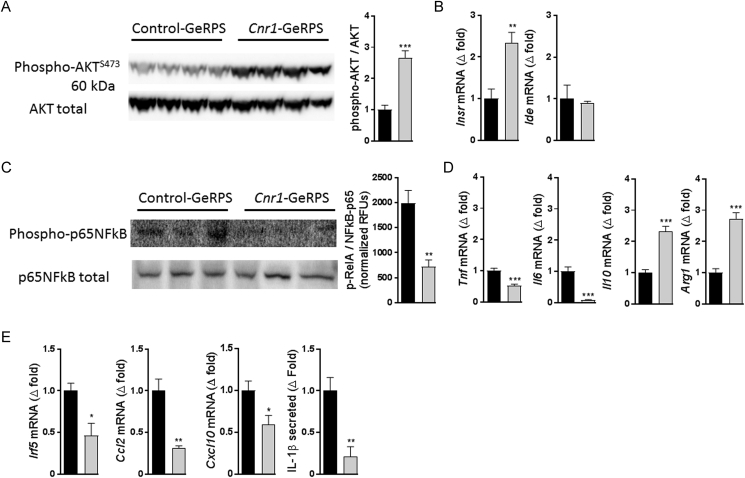
In vivo Cnr1 knock-down in KCs restores insulin signaling and promotes an anti-inflammatory profile. A Representative Akt phosphorylation by western blot after insulin stimulation and its quantification. B Gene expression of insulin receptor (Insr) and insulin degrading enzyme (Ide) in isolated Kupffer cells. C Representative NF-κB phosphorylation analysis by western blot and by cell-based ELISA kit. D Gene expression for TNFα (Tnf), IL-6 (Il6), IL-10 (Il10), and arginase 1 (Arg1) in isolated Kupffer cells. E Gene expression for interferon regulatory factor 5 (Irf5), CCL2 (Ccl2), CXCL10 (Cxcl10), and secretion of IL-1β from isolated Kupffer cells from obese mice treated either with control (black columns) or Cnr1-GeRPs (grey columns). Columns and bars represent means ± SEM. Significant differences from values in control-GeRPs treated DIO mice *P < 0.05, **P < 0.01, ***P < 0.001.